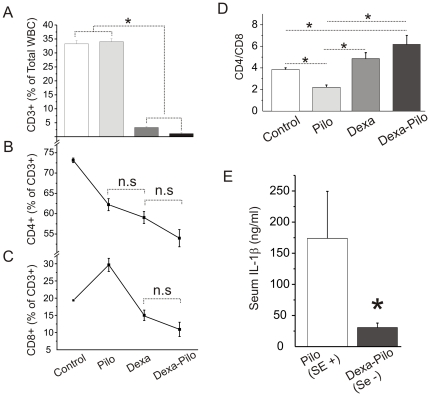
Hematologic and serologic changes after dexamethasone treatment in rats.